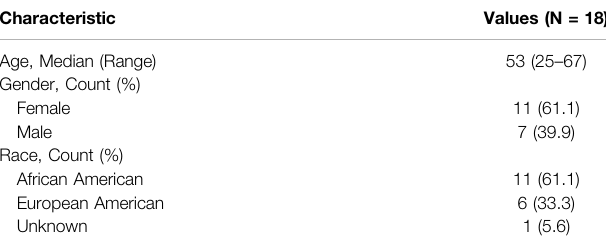
TABLE 1 | Cohort sociodemographic characteristics.